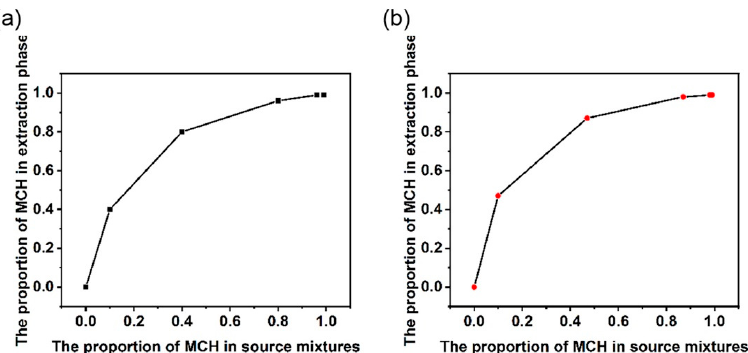
Figure 4. Extraction equilibrium curve of ( a ) WP5 and ( b ) WP6.